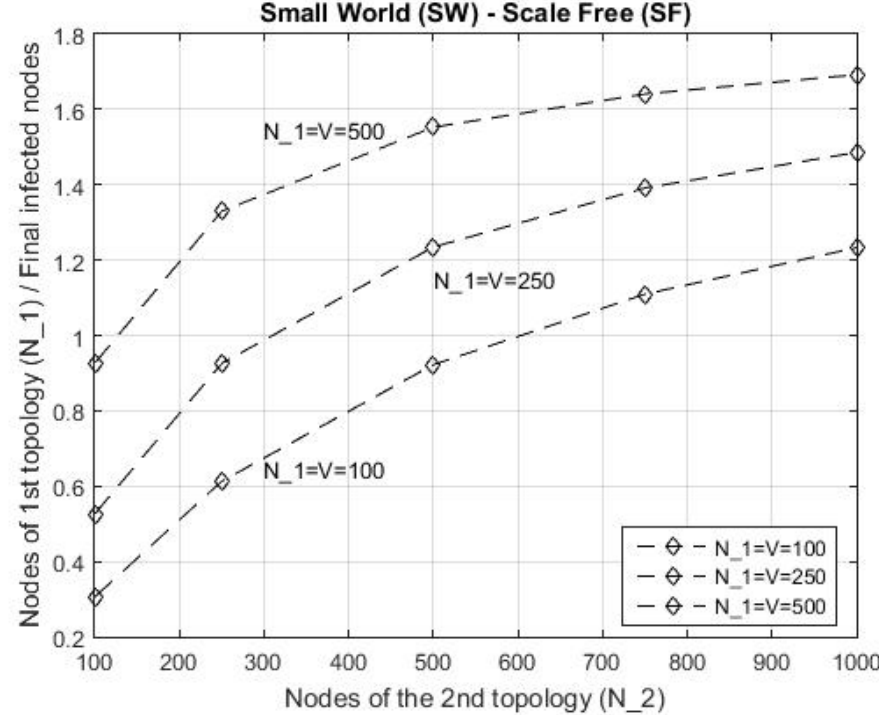
Figure 5. Small-World and Scale-Free, while N_1 = 100, N_1 = 250 and N_1 =